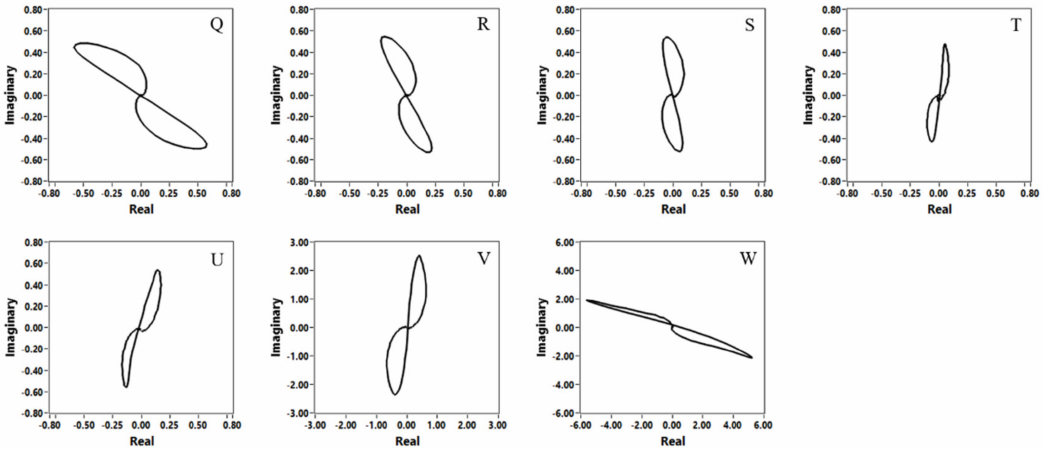
Figure 14. Lissajous curves from the front bobbin coils for the American Society of Mechanical Engineers (ASME) standard specimen (50 kHz AC).